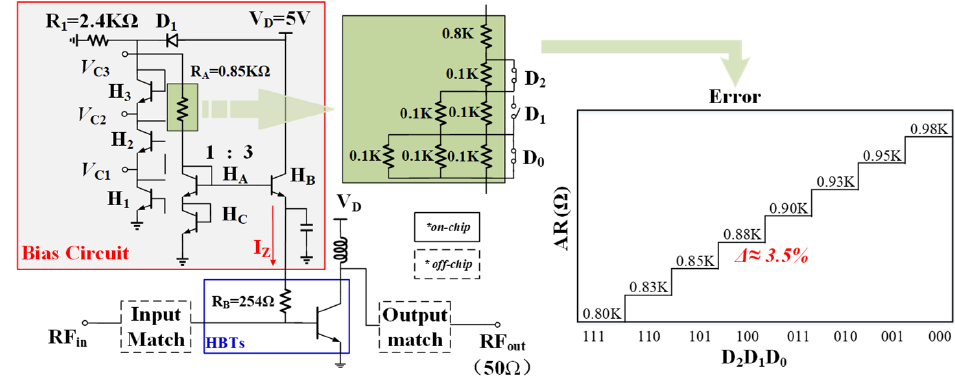
Figure 5. Schematic of PA with the proposed ZTAT current.